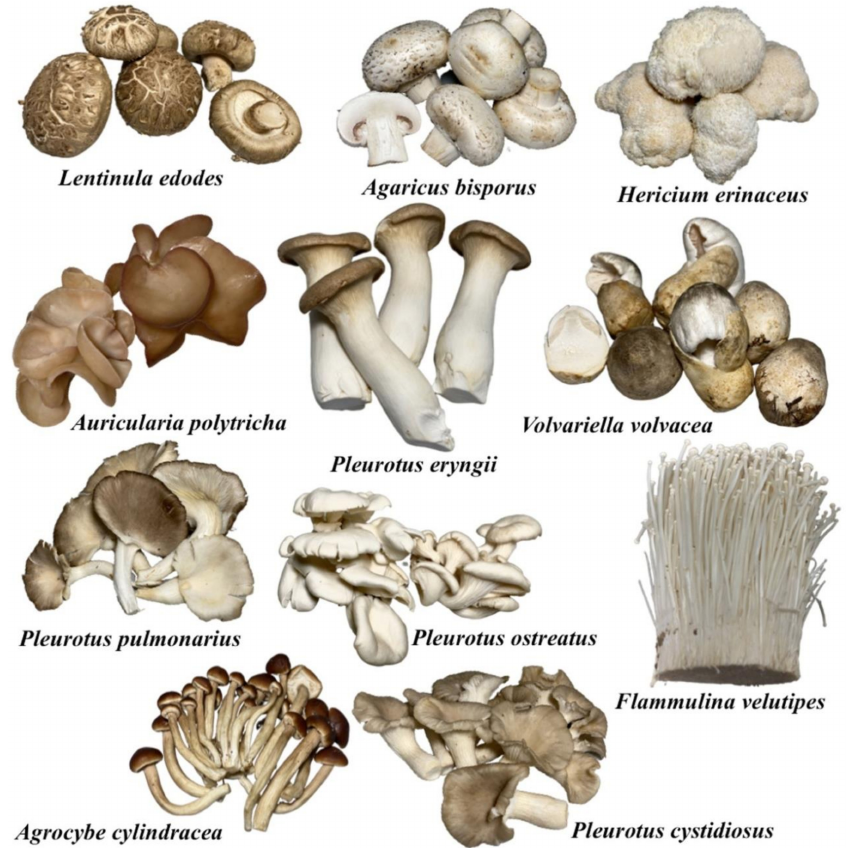
Figure 3. Examples of some commercially important cultivated